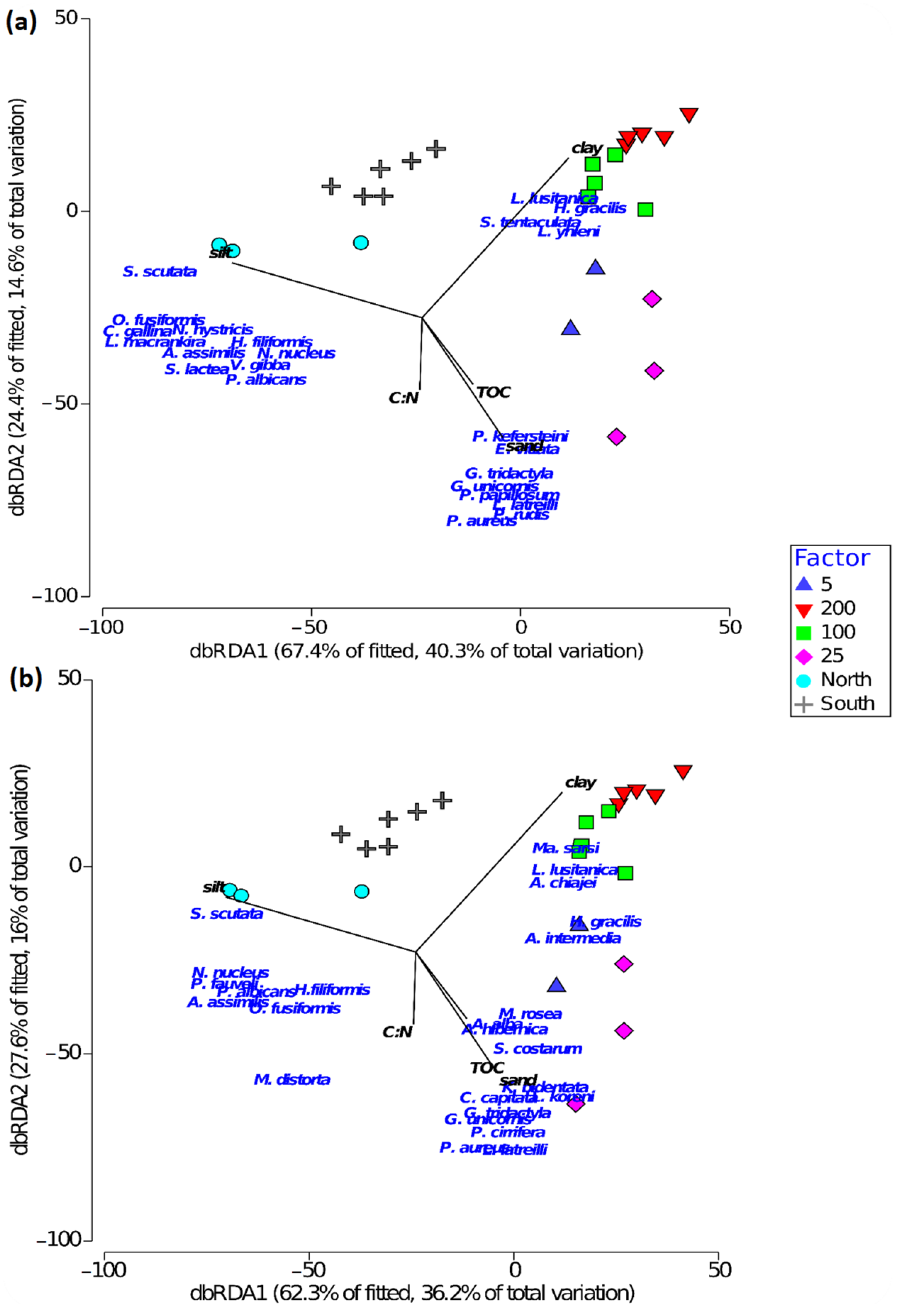
Figure 7. Distance-based redundancy analysis (dbRDA) performed using BPi ( a ) and IPi ( b ) values of species selected by SIMPER and environmental variables for both sampling areas. Arrows indicate environmental variables: sand, silt, Total Organic Carbon (TOC), Total Nitrogen (TN), and the ratio between carbon and nitrogen (C:N). See Table S2 for species names.